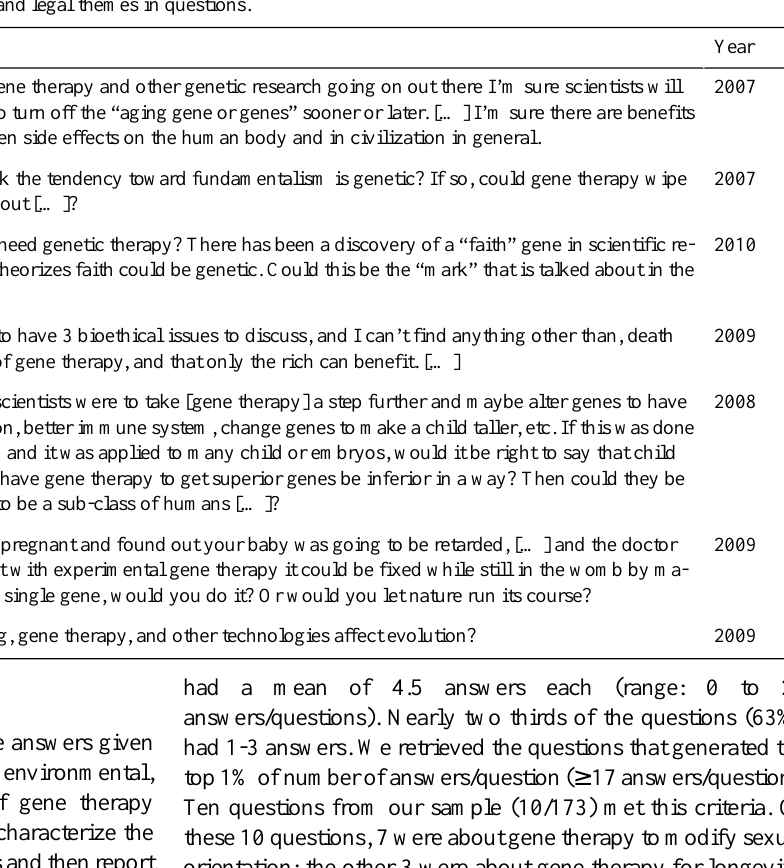
Table 4. Examples of ethics, environment, economic, and legal themes in